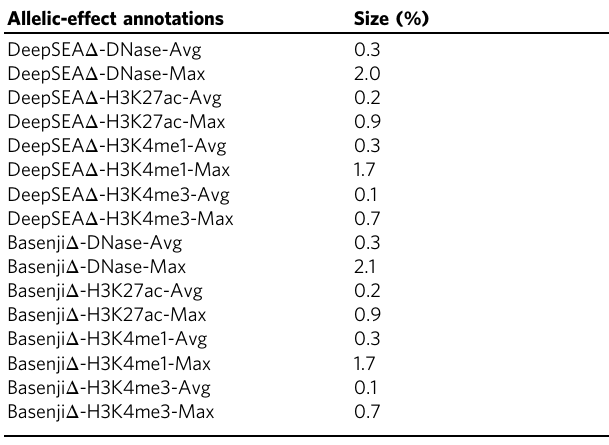
Table 1 List of non-tissue-speci fi c allelic-effect